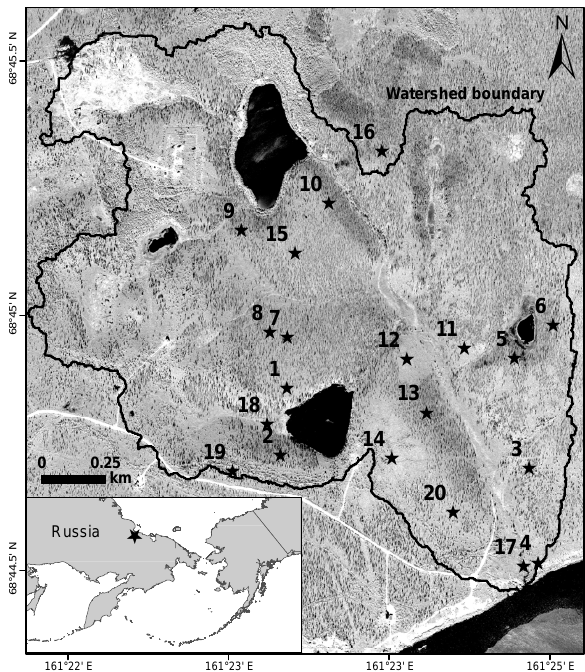
Figure 1. Location of the Y4 watershed in relation to Russia (inset) and location of the sampling sites within the Y4